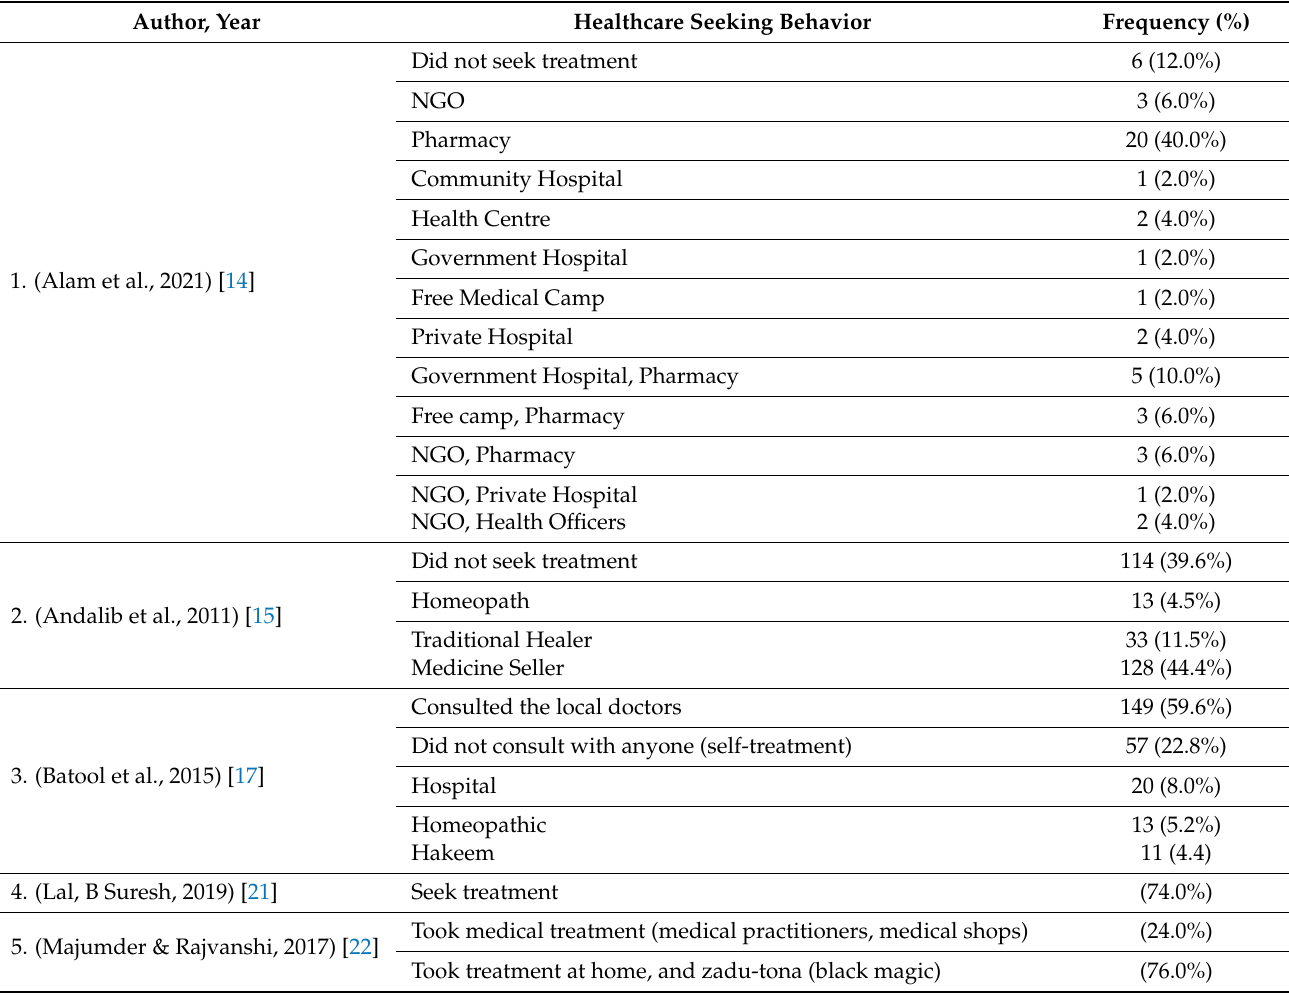
Table 7. Healthcare seeking behavior among child waste